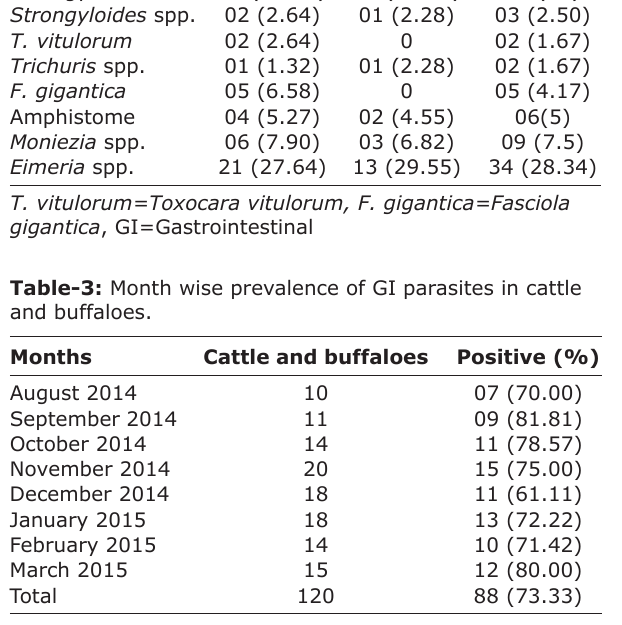
Table-4: EPG/OPG of GI parasites in cattle and buffaloes. Parasites